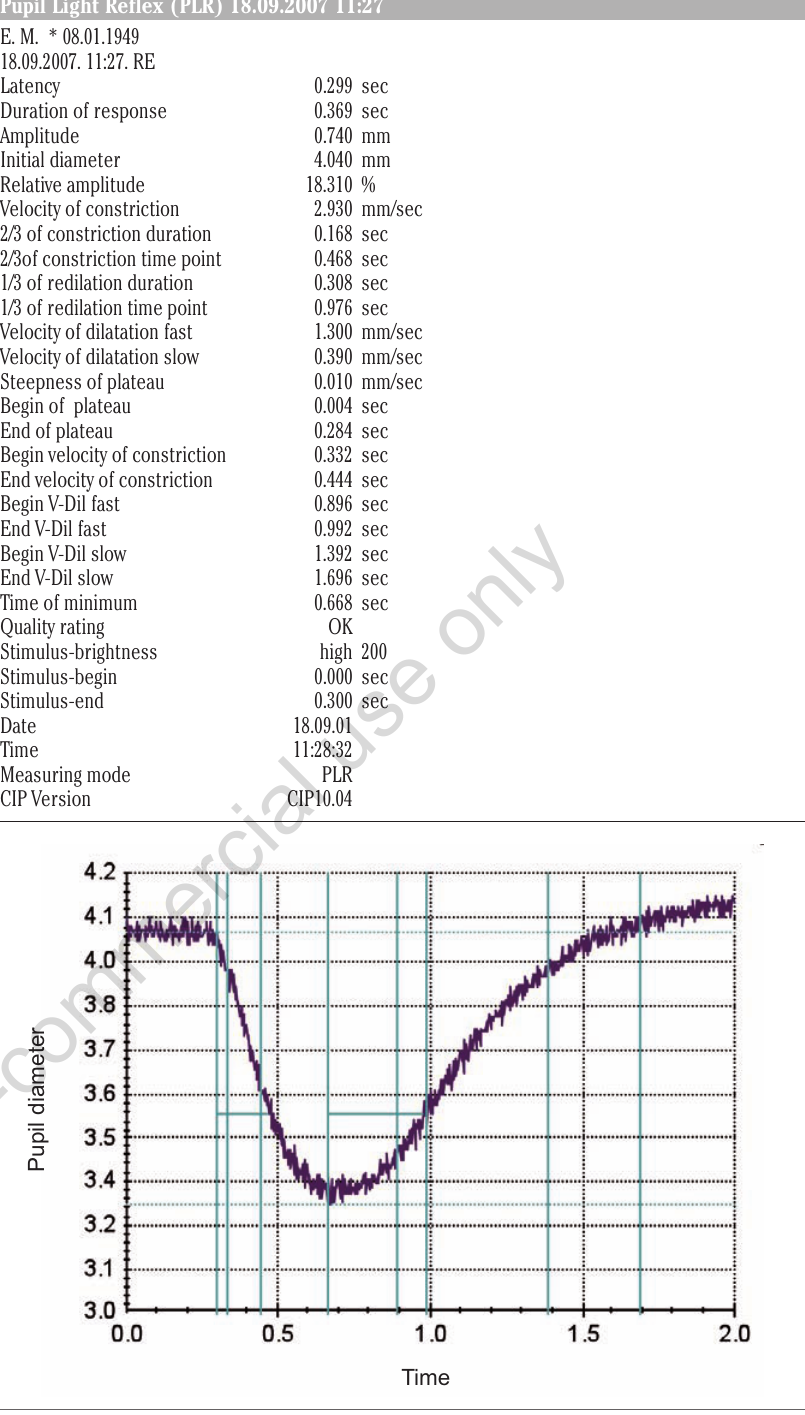
Figure 1. Example printout of pPLR time and dynamic variables and pPLR